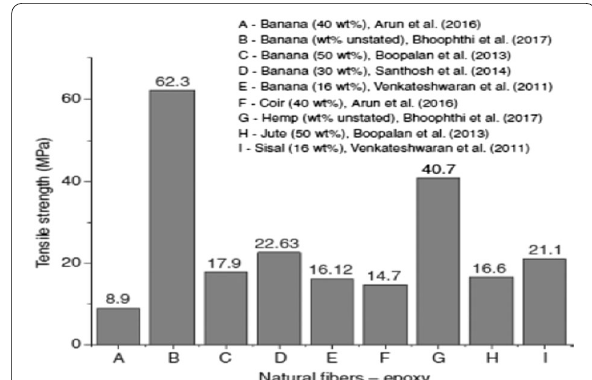
Fig. 7 Tensile strength of natural fibre-reinforced epoxy composites (Kulkarni et al. 2019)